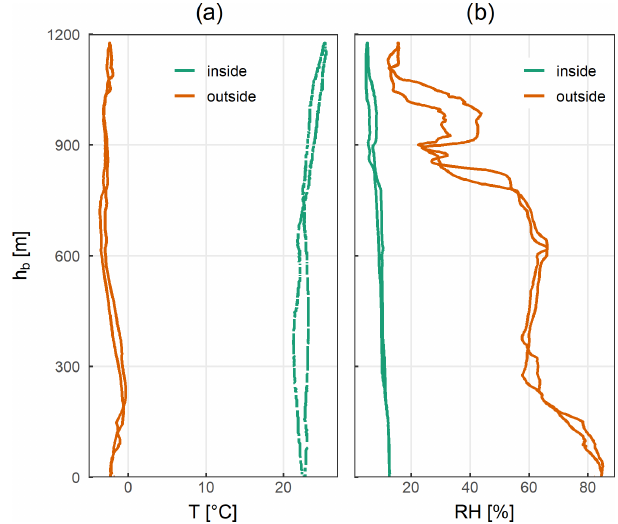
Figure 7. Vertical profiles of (a) temperature ( T ) and (b) relative humidity (RH) inside CAMP downstream of the dryer, measured on a balloon flight in Melpitz on 21 January 2019. Ambient measure- ments outside CAMP were taken from the external meteorological sensor